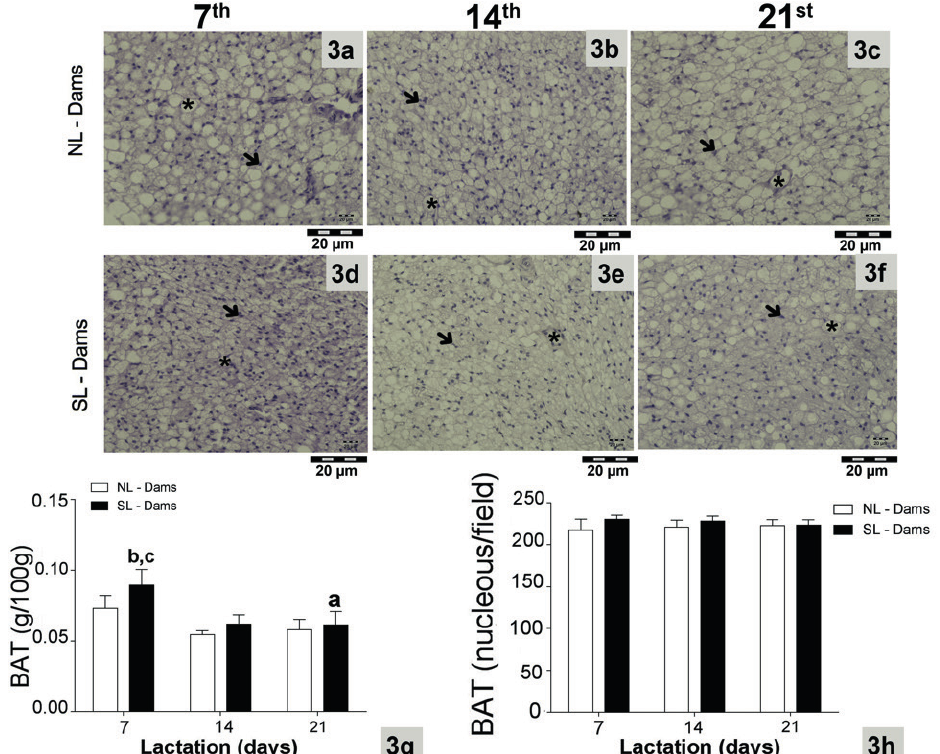
Figure 3 - Histological analysis of the BAT from lactating SL-dams and NL-dams during different lactational phases. The values are expressed as mean ± Standard Error of the Mean (n= 8-12 animals/ group). The symbol above bars indicates a significant difference (p<0.05) between the groups (Two-way ANOVA with uncorrected Fisher´s LDS: a 7 th day of lactation; b 14 th day of lactation and c 21 st day of lactation). The arrows in the image indicate the adipocyte nucleoli and the asterisks in the image indicate the